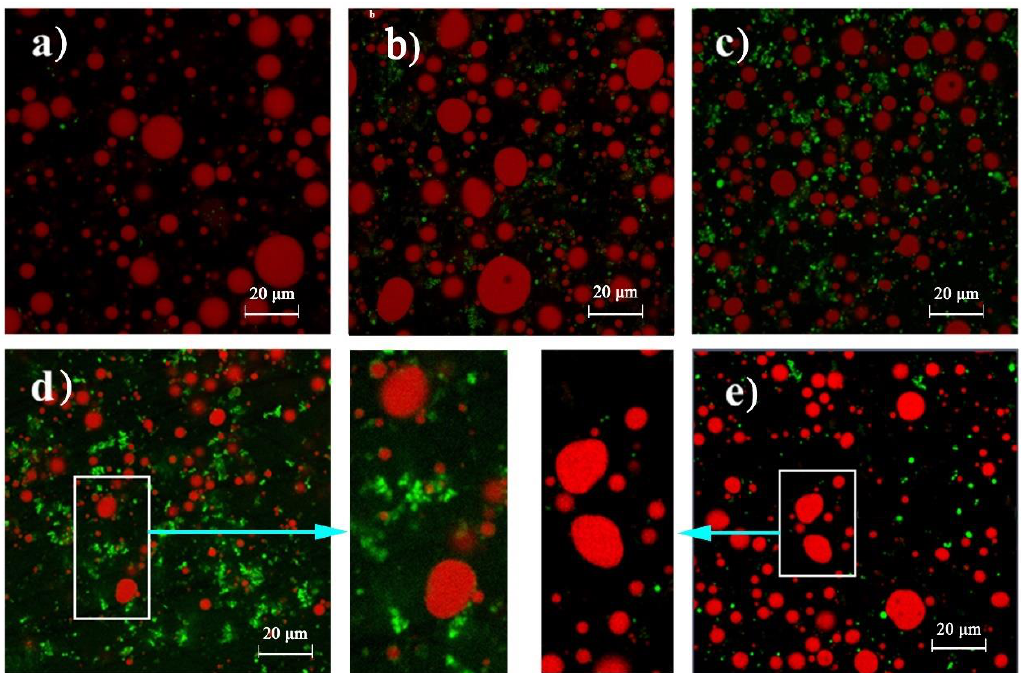
Figure 6. Confocal laser scanning microscopy images of model mayonnaises containing different concentrations of the flaxseed gum (FG) and whey protein microparticles (WPMs). ( a ) 0.3 wt% FG + 0 wt% WPMs, ( b ) 0.3 wt% FG + 8 wt% WPMs, ( c ) 0.3 wt% FG + 16 wt% WPMs, ( d ) 0.3 wt% FG + 24 wt% WPMs, ( e ) 0.6 wt% FG + 0 wt% WPMs.